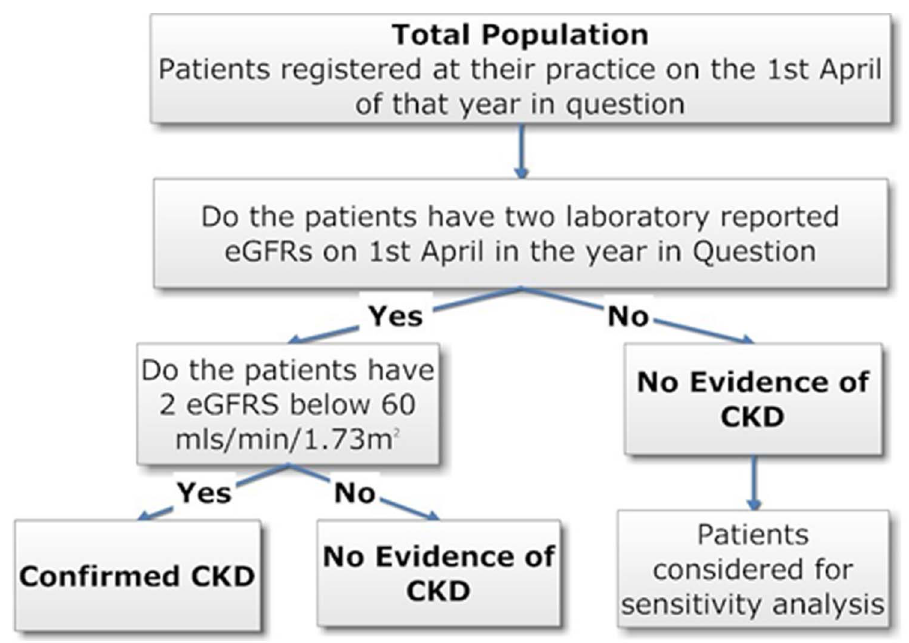
Figure 1. The definition of Stages 3–5 CKD in the prevalence cohort.